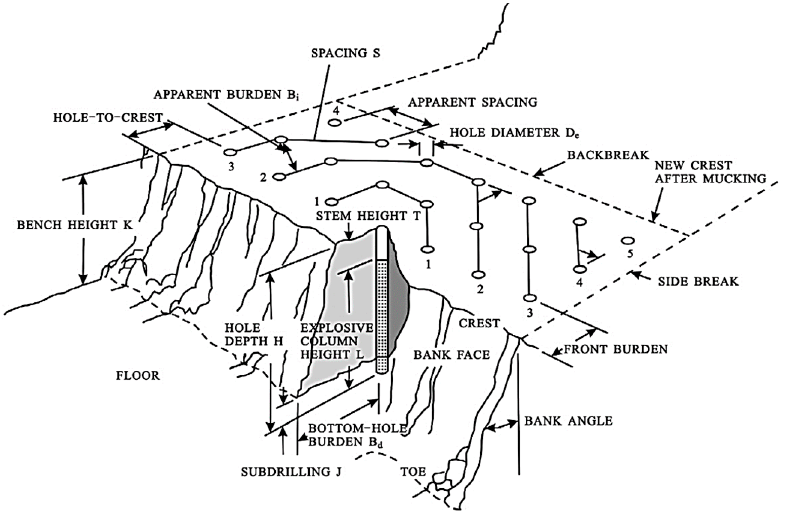
Figure 1. Blast design terminology [5].